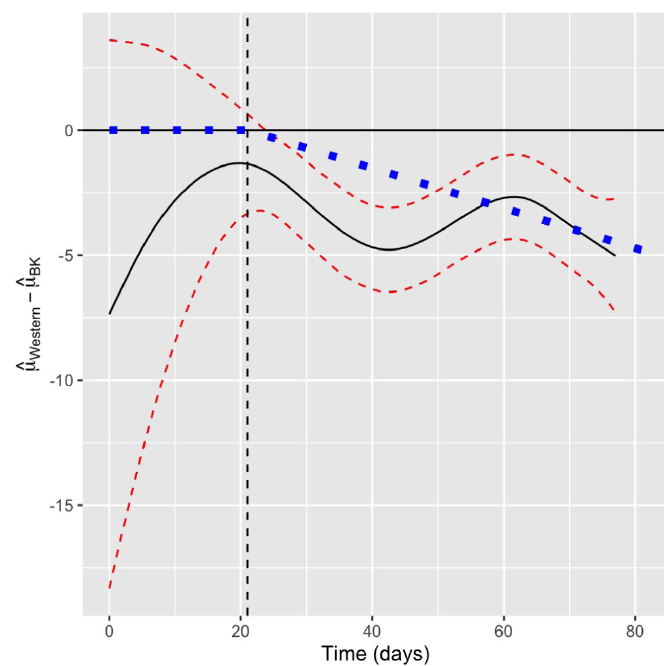
Figure 5. Estimated functional form of the longitudinal differential abundance for the Western diet group from Turnbaugh et al . 10 study for the Genus Sutterella with the corresponding functional form chosen for the simulation shown in blue. The black line represents the point estimate with the dashed red lines corresponding to 95% confidence intervals fit using Gaussian smoothed spline